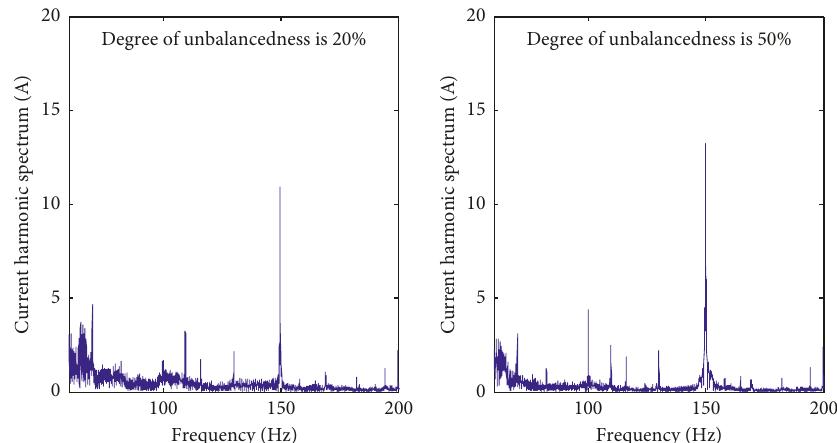
Figure 19: Current waveforms and harmonic spectrum of the DFIG under three-phase voltage unbalance. Table 3: Model parameter correction.